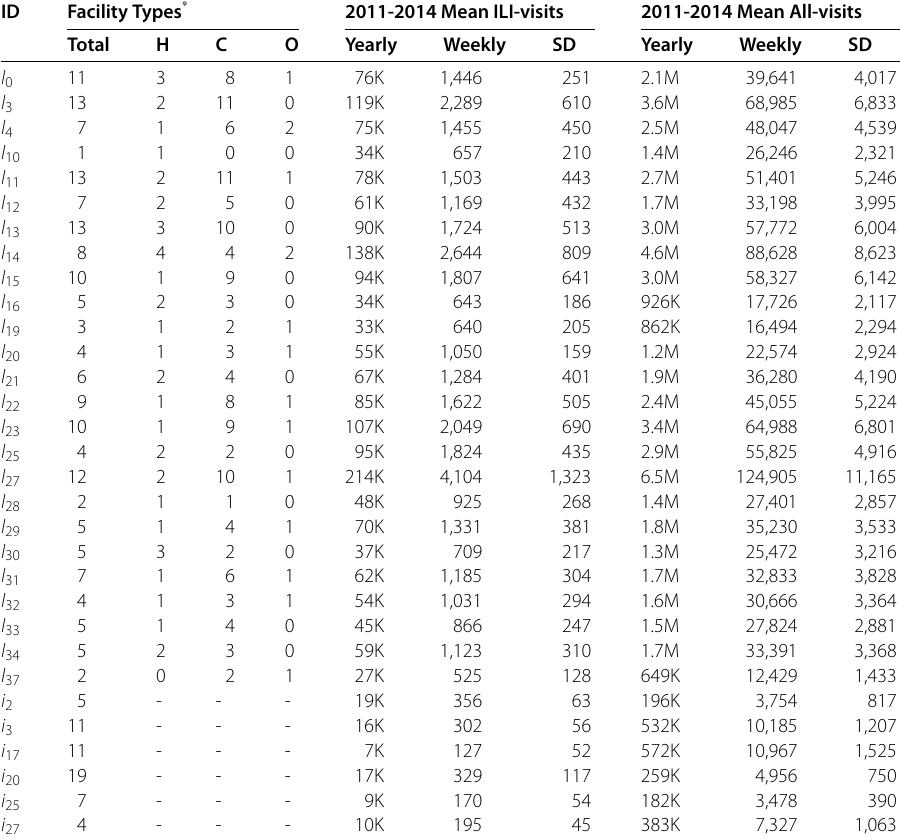
Table 2 The geolocation’s facility types, mean ILI-visits, and mean all-visits for